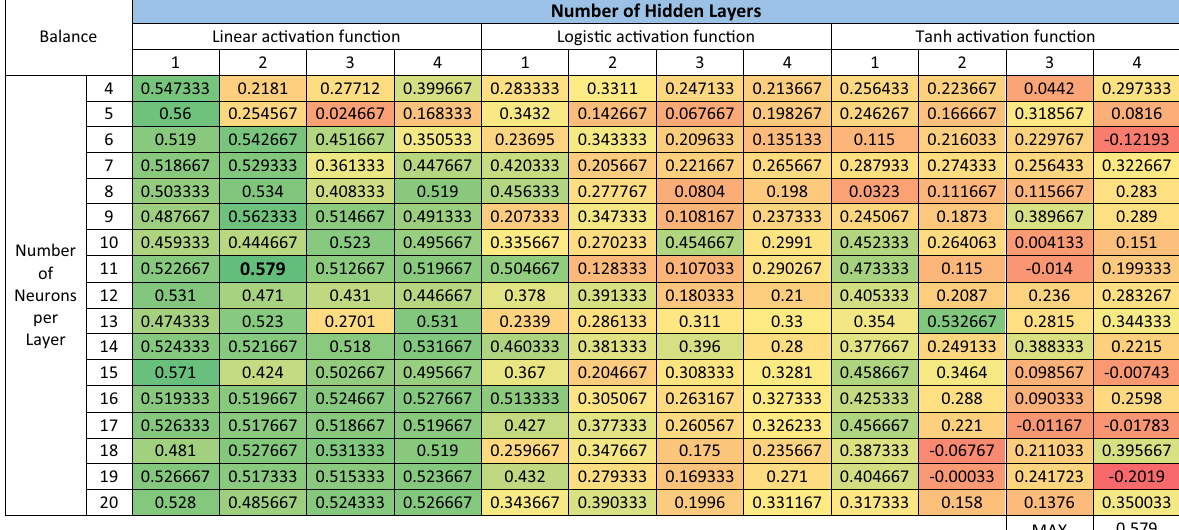
Number of Hidden Layers